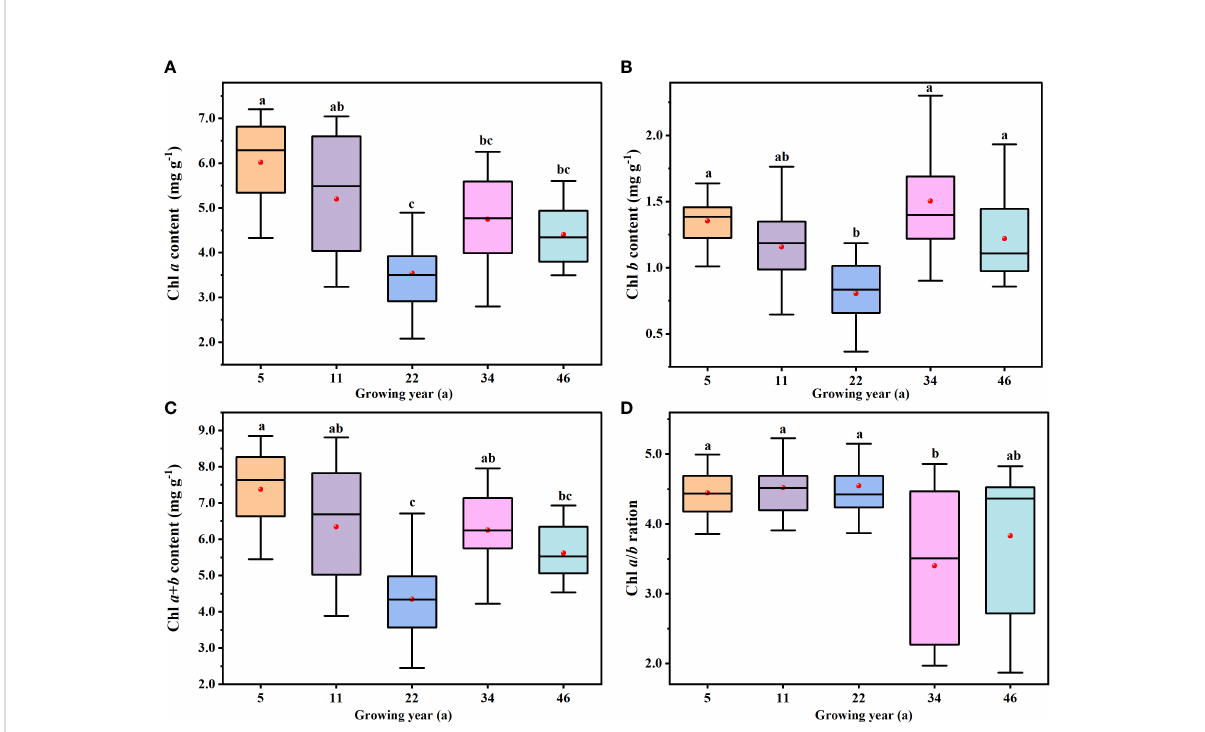
FIGURE 4 The variations in leaf chlorophyll content and ratio at different stand ages. (A – D) Calculated in Chl a , Chl b , Chl a + b , and Chl a / b , respectively. The black lines across the boxes are median values, and the red points represent the mean values. The same letters denote no signi fi cant difference among the different stand ages of Haloxylon ammodendron ( P <